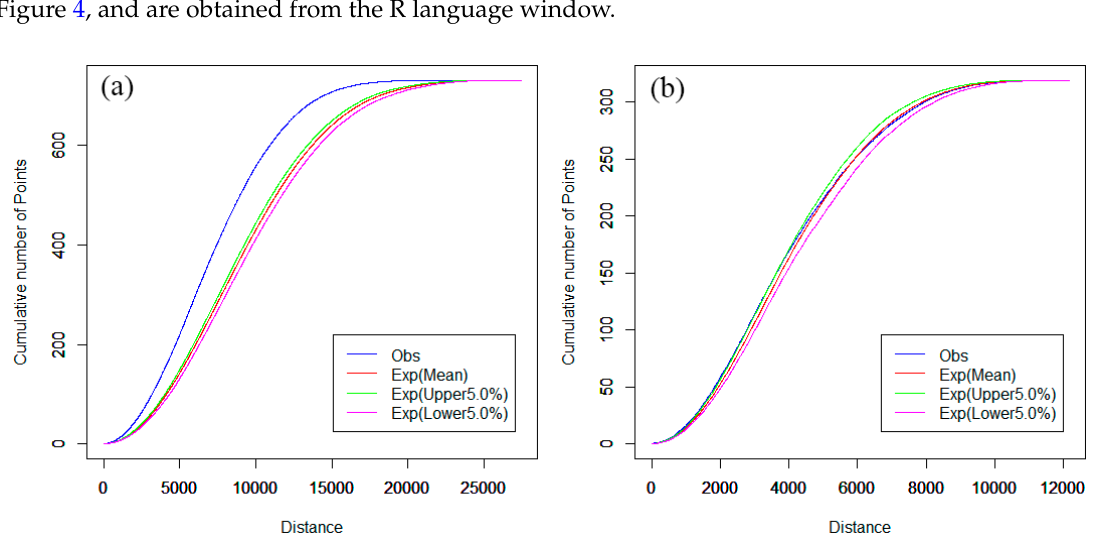
Figure 4. ( a ) Network auto K-function analysis of main urban districts and ( b ) network auto K-function analysis of downtown area.